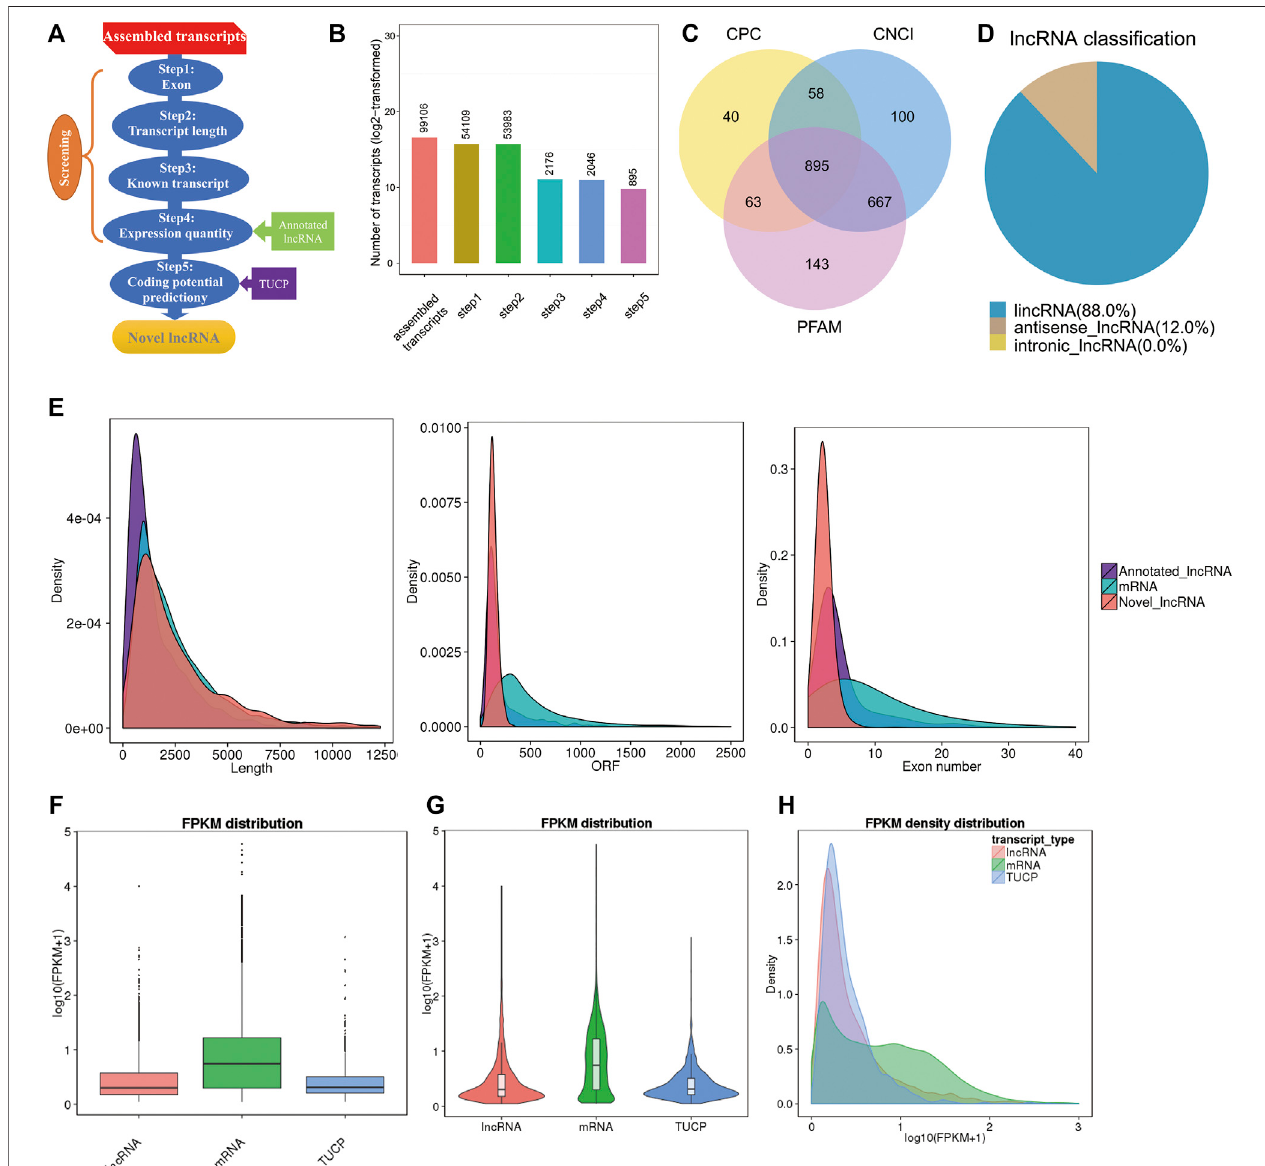
FIGURE1| Characterizationofpre-ovulatoryfolliclesforgoatlncRNAs,mRNAs,andTUCPs. (A,B) .StepsofthenovellncRNAscreening. (C) Codingpotency fi lter withthreemainstreamcodingpotentialanalyticalmethods(CPC,CNCI,andFFAM). (D) Classi fi cationofthelncRNAsidenti fi edhere. (E) Transcriptsizedistribution,ORF length, and exon number of lncRNA and mRNA transcripts. (F − H) Box plot, violin plot, and density distribution diagram showing the expression features of lncRNAs, mRNAs, and TUCPs in the pre-ovulatory follicles of goats.